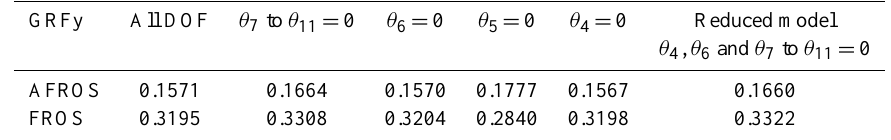
Table 1. RMS values of predicted GRFy (normalized by BW) with respect to the experimental values.